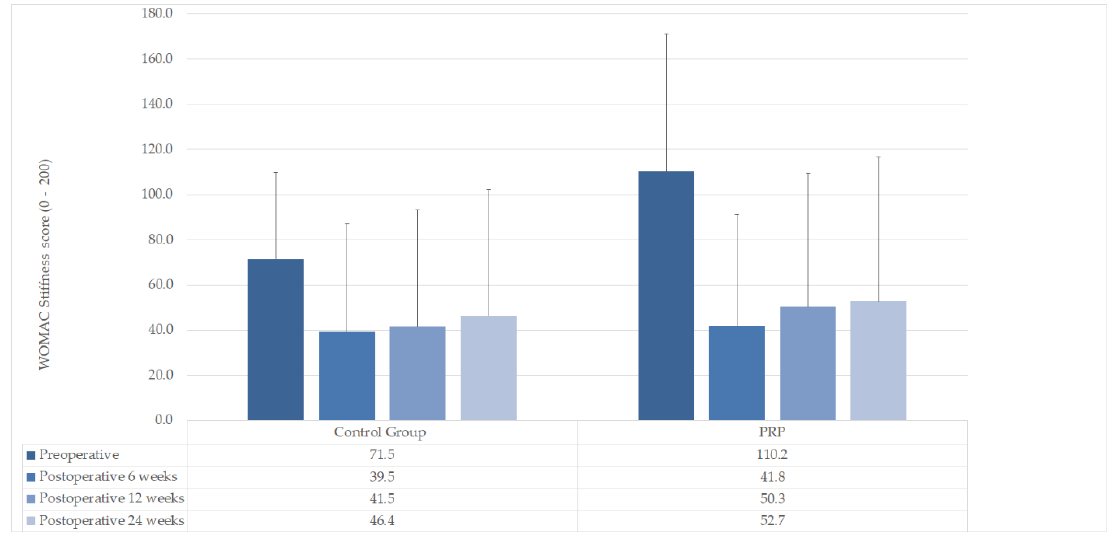
Appl. Sci. 2020 , 10 , x FOR PEER REVIEW Figure 4. Preoperative vs postoperative stiffness WOMAC scores. Figure 4. Preoperative vs postoperative sti